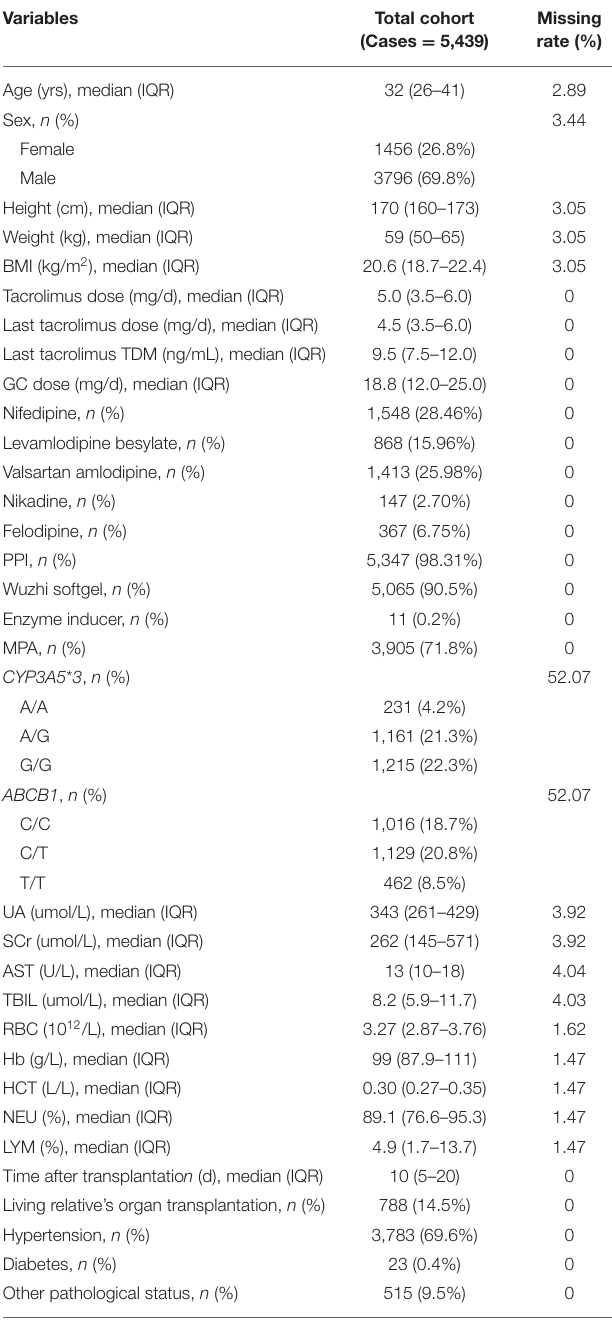
TABLE 1 | Baseline characteristic of study